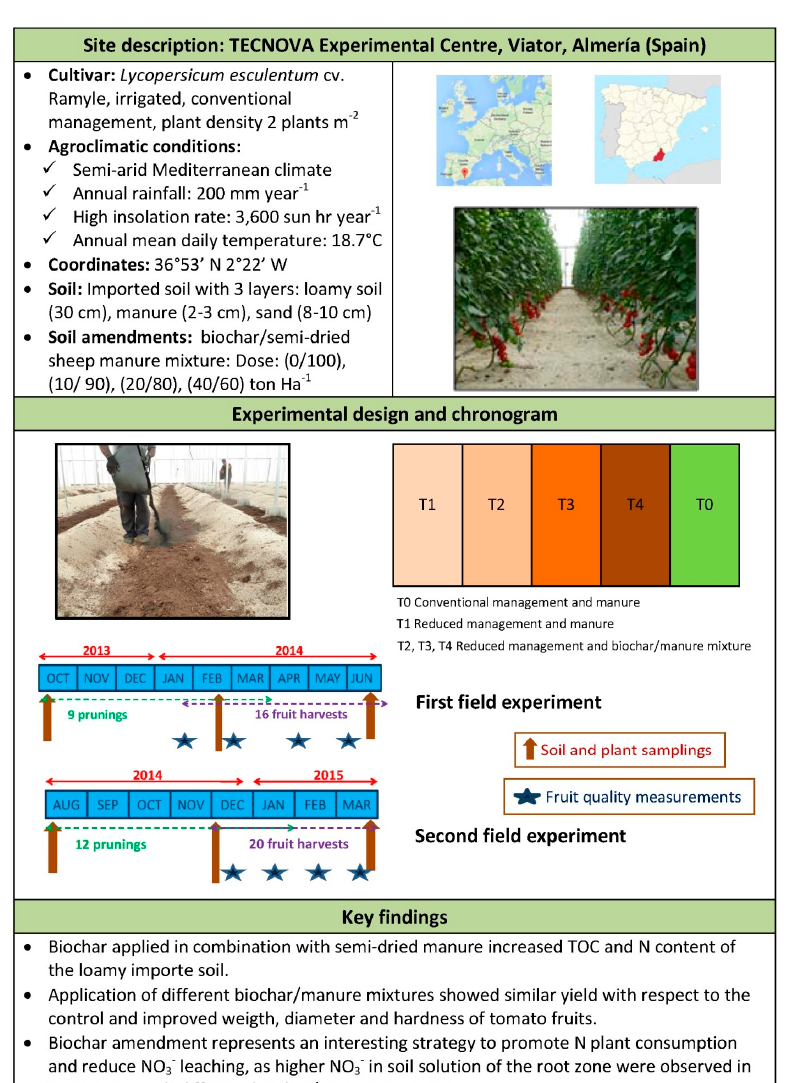
Figure 4. Description of the field scale experiment at Almería (Spain): greenhouse tomato crop.